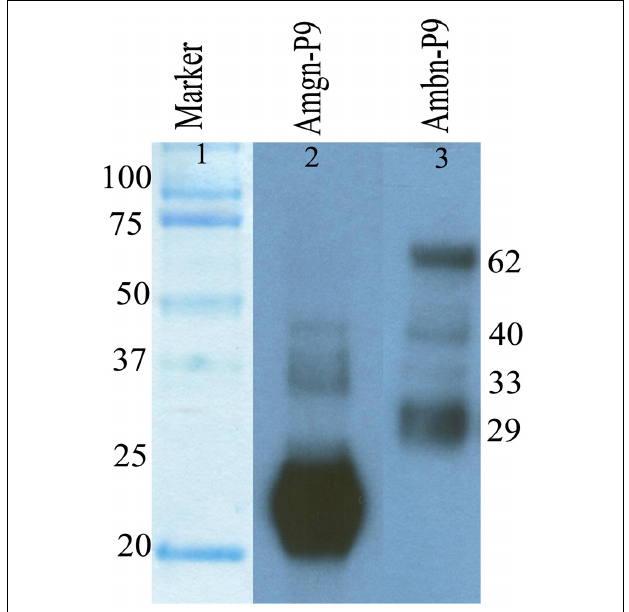
FIGURE 2 | Immunochemical detection of amelogenin (lane 2) and ameloblastin (lane 3) proteins and their degradation products present in enamel matrix from postnatal day 9 old (P9) mouse